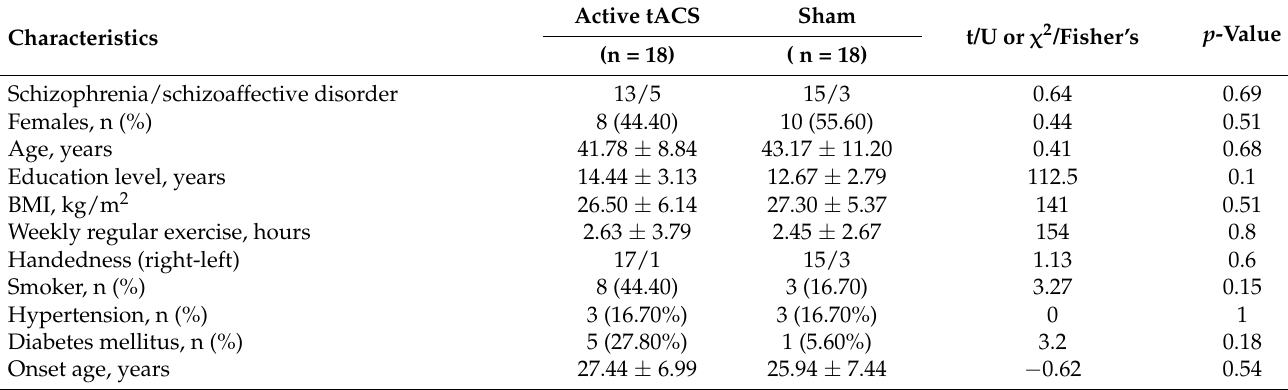
Figure 3. The CONSORT flow diagram of the progress through the phases of the randomized sham-controlled trial. Table 1. Baseline sociodemographic and clinical characteristics of the participants.